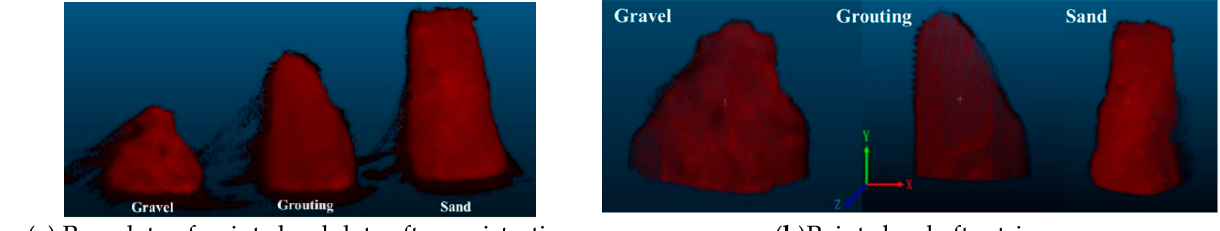
trimmed for the roughness analysis, which is shown in Figure 5b.